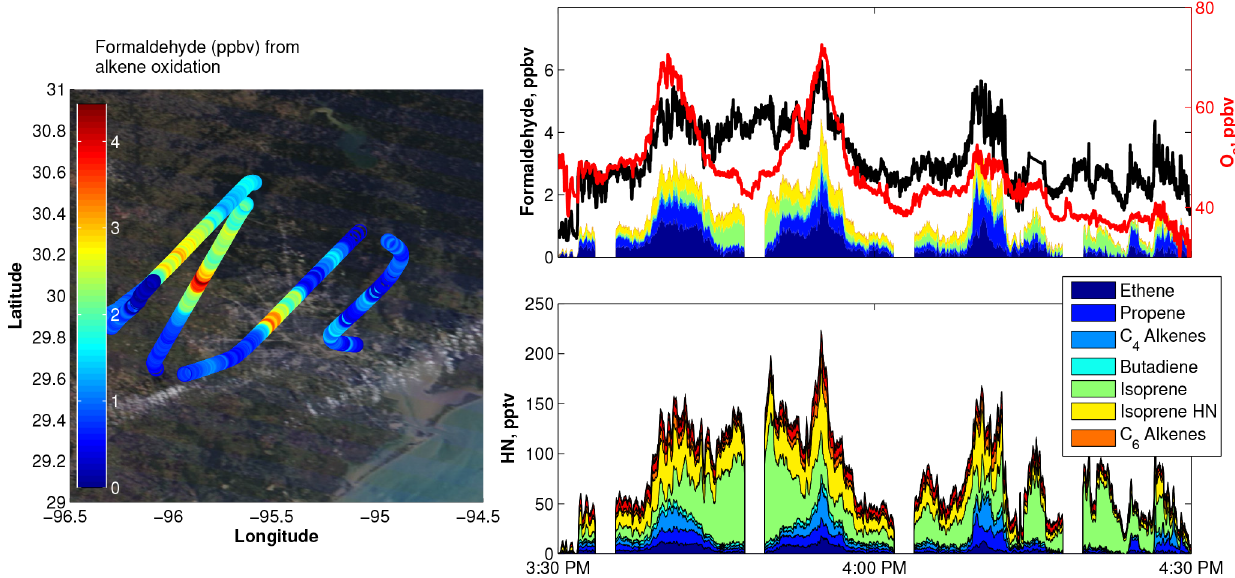
Figure 8. Atmospheric hydroxy nitrate, O 3 and formaldehyde data measured in the Houston plume from the 2013 SEAC4RS campaign. The lower right panel shows how each hydroxy nitrate contributes to the total hydroxy nitrate measured by the Caltech CIMS for the data taken from a flight over Houston on 18 September 2013. As the plane crosses into the Houston plume, hydroxy nitrates derived from anthropogenic emissions are enhanced. The upper right panel shows formaldehyde (black, left axis) and ozone (red, right axis) are strongly correlated with anthropogenically derived hydroxy nitrates. Additionally, the lower bound estimates for the formaldehyde directly attributable to oxidation of each alkene in-plume using the branching ratios derived in this study are shown in colors. For ethene, the contribution is adjusted to produce two formaldehyde molecules after alkoxy decomposition, and uses a decomposition yield of 0.8 to account for glycolaldehyde formation from reaction of the alkoxy radical reaction with O 2 . For isoprene hydroxy nitrate, a branching ratio estimate of 0.12 was used (Paulot et al., 2009). It was assumed that the sum of methyl vinyl ketone hydroxy nitrate (MVKN) and methacrolein hydroxy nitrate (MACRN) are exclusively derived from isoprene hydroxy nitrates with a yield of 1 formaldehyde per each isoprene HN oxidized to form a MVKN or MACRN molecule (Lee et al., 2014), and, therefore, a branching ratio estimate of 0.11 was used. Ozone observations were provided courtesy of Ryerson, Pollack and Peischl at NOAA ESRL. Formaldehyde observations provided courtesy of Hanisco and Wolfe at NASA. The left panel graphs the flight tracks for this section of the flight colored by the lower bound estimate of formaldehyde formed from oxidation of alkenes. Satellite image courtesy of NASA’s